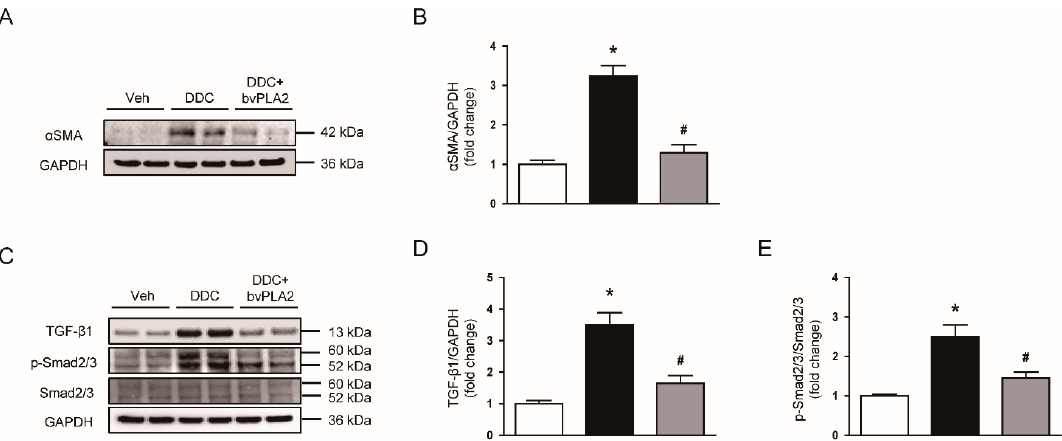
Figure 4. Effect of bvPLA2 on α -smooth muscle actin ( α -SMA) expression and transforming growth factor- β 1 (TGF- β 1) signaling cascade in DDC diet-fed mice. ( A ) Western blotting of α -SMA in liver tissues. ( B ) Quantification of western blot for α -SMA. ( C ) Western blotting of TGF- β 1 and p-Smad2/3 in liver tissues. ( D ) Quantification of western blot for TGF- β 1 ( E ) Quantification of western blot for p-Smad2/3. n = 8 per group. * p < 0.05 vs. Veh. # p < 0.05 vs. DDC.